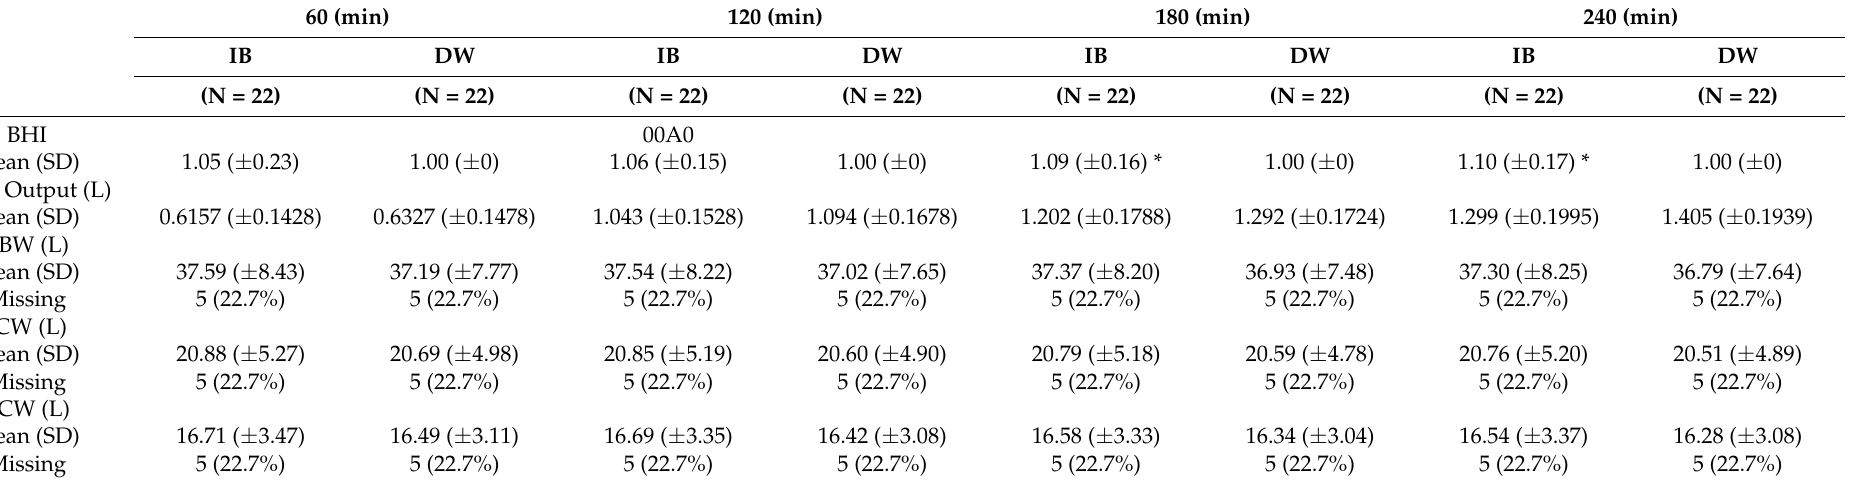
Table 2. Differences in hydration biomarkers throughout the 240 min post ingestion of either isotonic beverage (IB) or distilled water (DW). * = p <